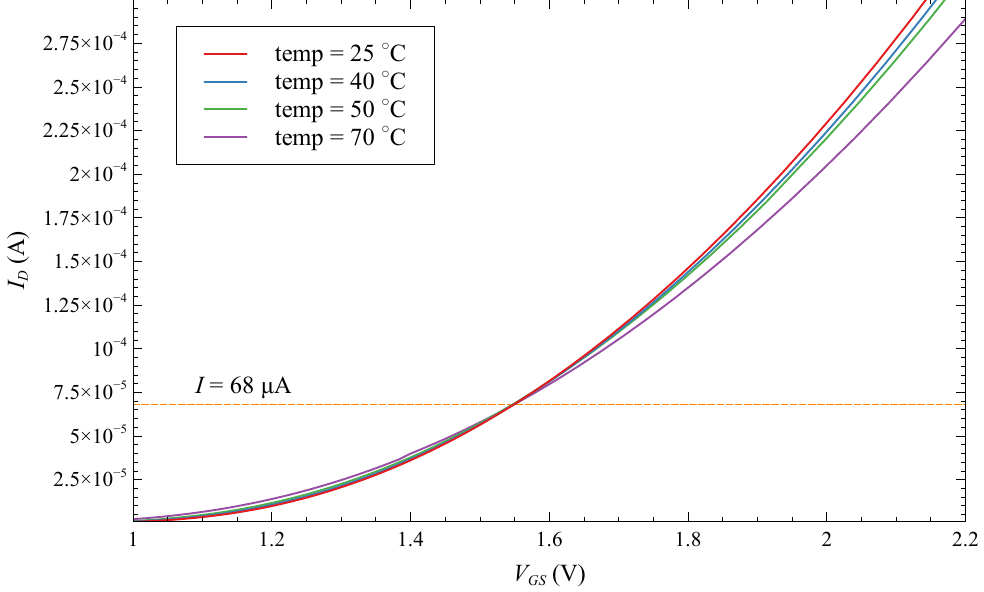
Figure 11. Transfer characteristics of EPADs for different ambient temperatures—Determination of Zero Temperature Coefficient